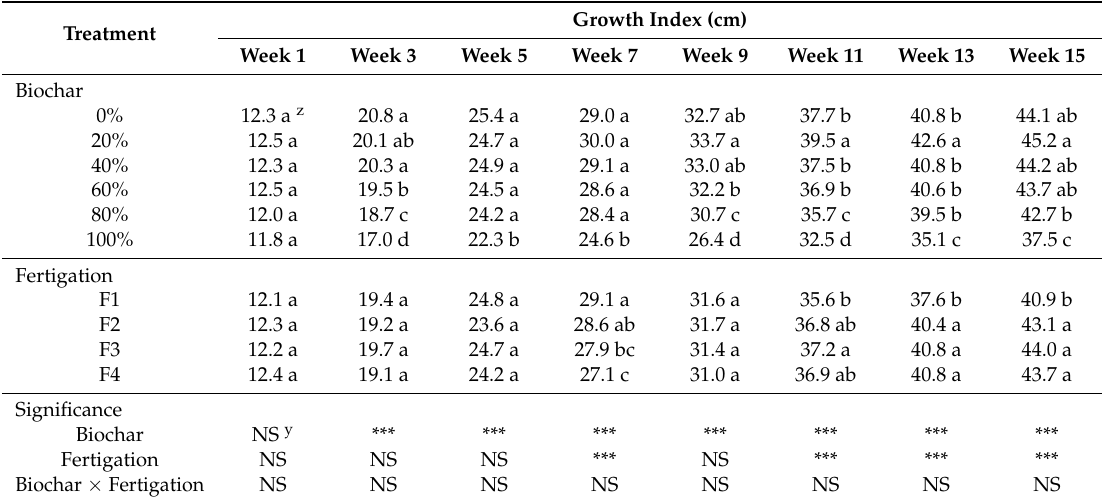
Table 2. Growth index of ‘Prestige Red’ poinsettia grown in Sunshine Mix #1 amended with six different percentages of biochar and fertigated at four regimes from Week 1 to Week